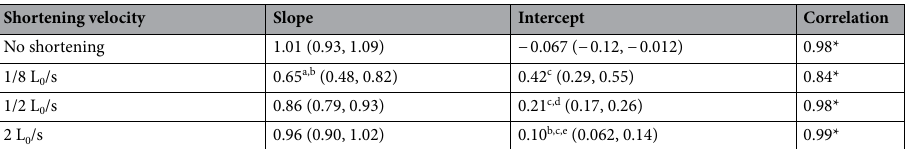
Shortening velocity Slope